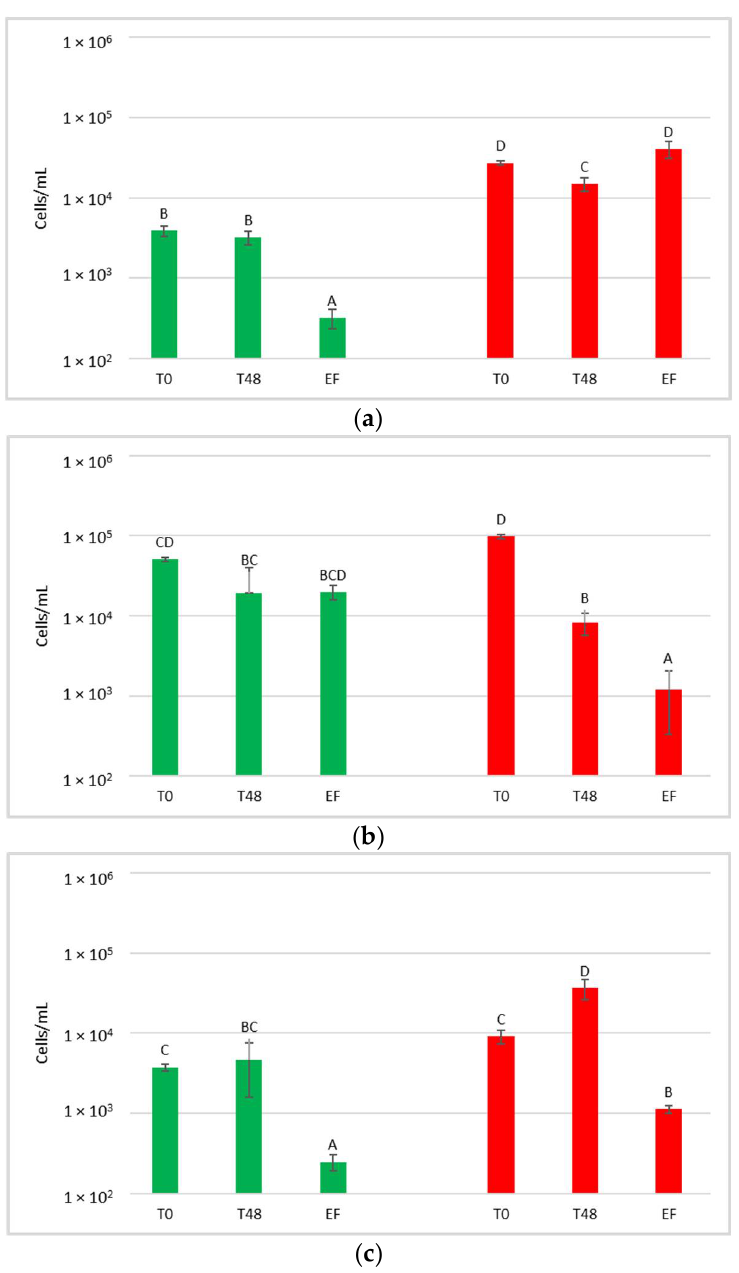
Figure 5. Starmerella bacillaris concentrations measured during fermentation of natural grape must. ( a ) JUICE, ( b ) CRYO and ( c ) JUICE + MARC. LCC: low cell concentration (green), HCC: high cell concentration (red). Data are expressed as the average of three replicates ± standard deviations. For each figure, different letters indicate significant differences between values ( p = 0.05).